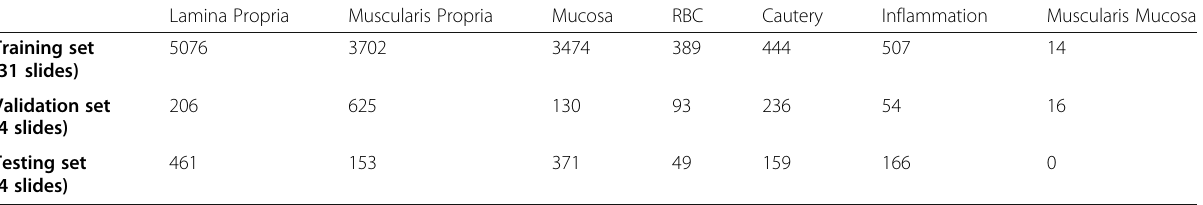
Table 1 The number of tiles in the training, validation, and test slides. Each tile is of size 512 × 512 pixels Lamina Propria